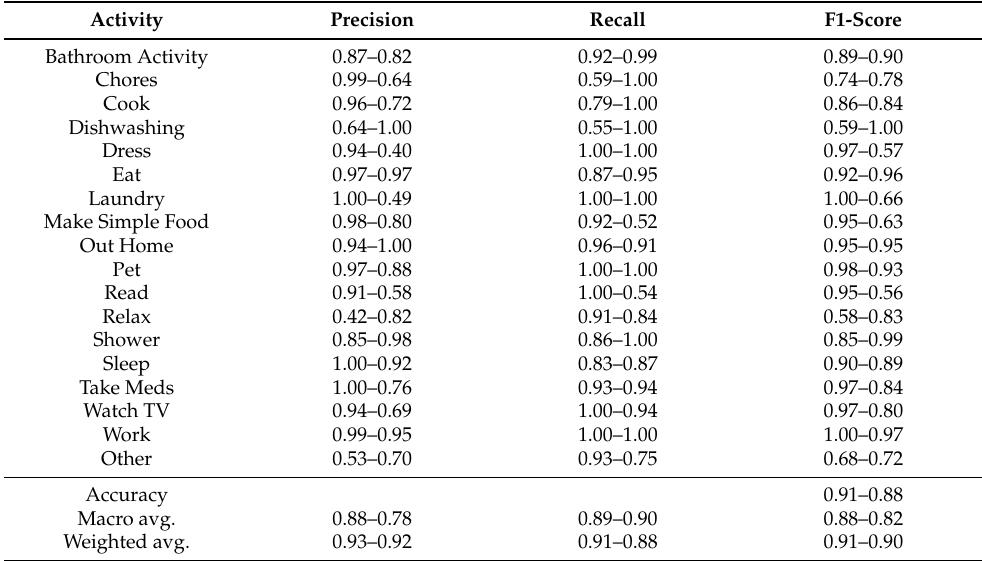
Table 6. Summary table of results by activity (User 1–User 2). Activity Precision